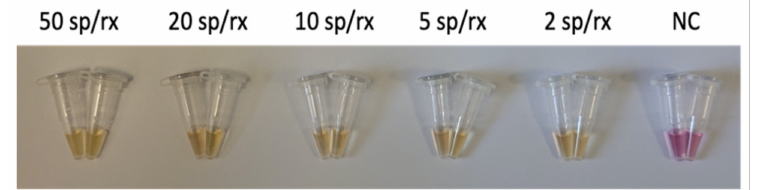
Figure 4. Representative colorimetric LAMP results for C. tyrobutyricum spore detection in water at different spore/reaction (sp/rx) concentrations. NC: negative control. All experiments were performed in quadruplicate, each being repeated at least three times.